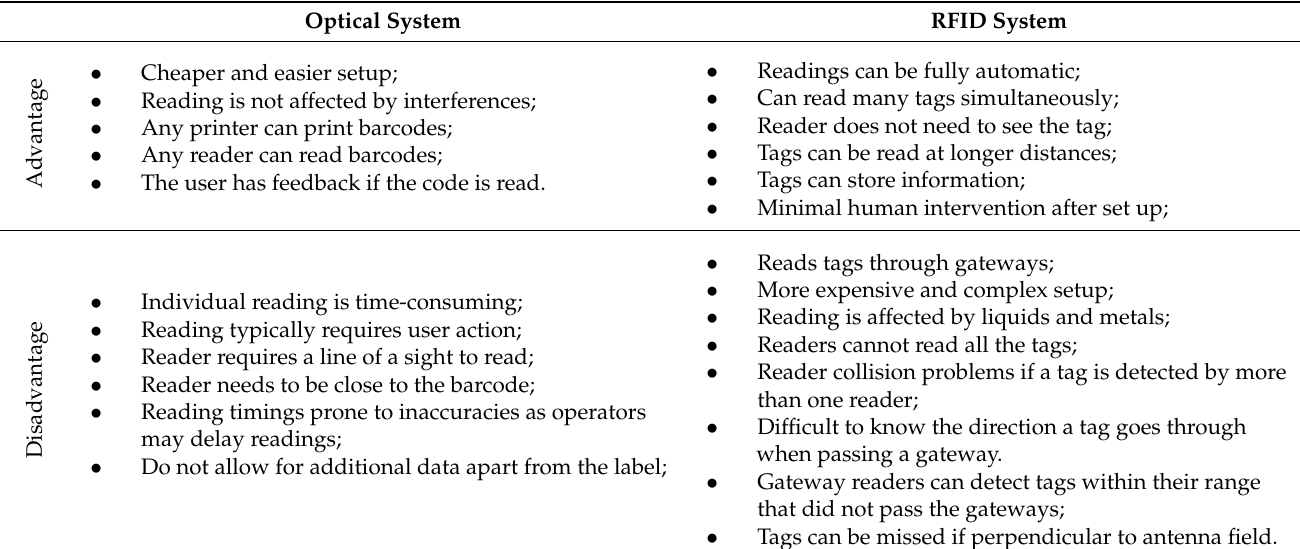
Table 3. Optical vs. RFID for real-time decision-making.